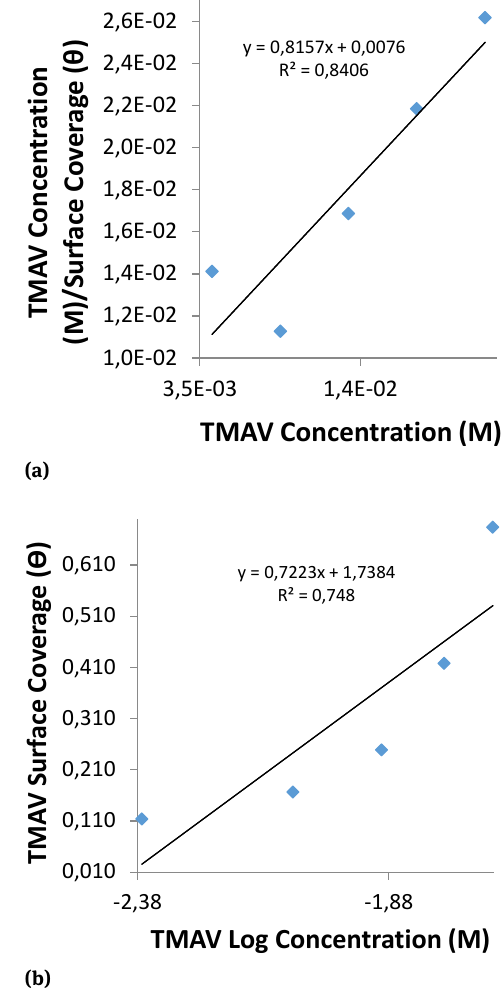
Figure 9: Adsorption isotherm plot (a) Langmuir isotherm and (b) Frumkin isotherm in H 2 SO 4 solution